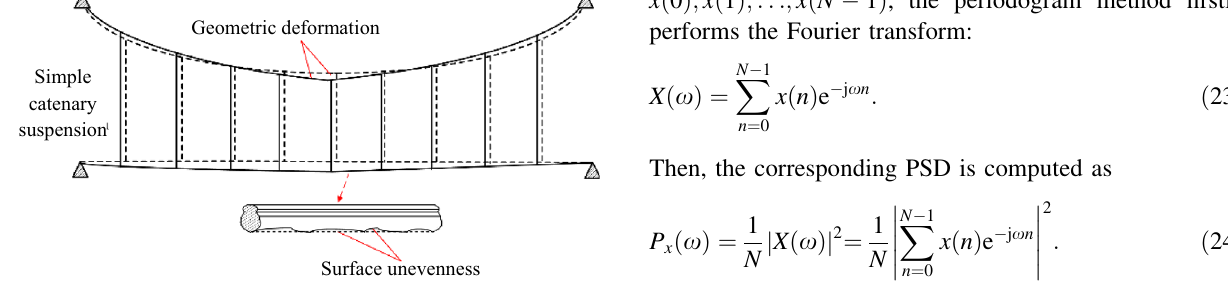
Fig. 12 Sketch of contact